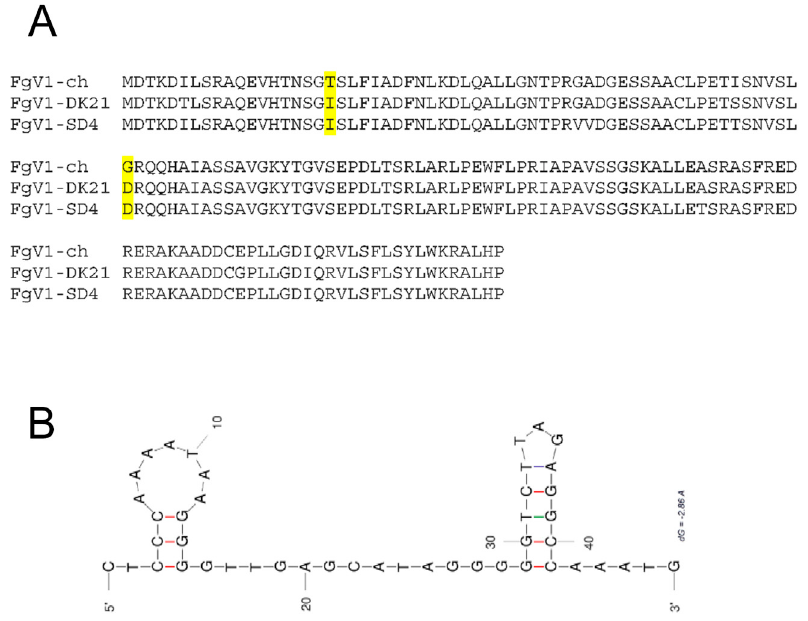
Figure 2. Amino acid changes in FgV1 ORF2-encoded protein (pORF2) alignment and predicted 3 ′ - UTR secondary structure of FgV1-SD4 were speculated to explain the hypovirulence effects. ( A ) Amino acid alignment of pORF2 among FgV-1-ch, FgV1-DK21, and FgV1-SD4. ( B ) The predicted 3 ′ -UTR (CTCCCAAAATAAGGGGTTGAGCATAGGGGGTCTTAGAGGCCAAATG) secondary structure of FgV1-SD4 with hairpin loops (UNAfold, DINAMelt quickfold, and mfold); initial Δ G = − 9.00. The highlighted amino acid residues indicate the two residues different among the three reported viral variants which could be associated with different levels of hypovirulence observed. Table 1. List of primers used in this chapter.